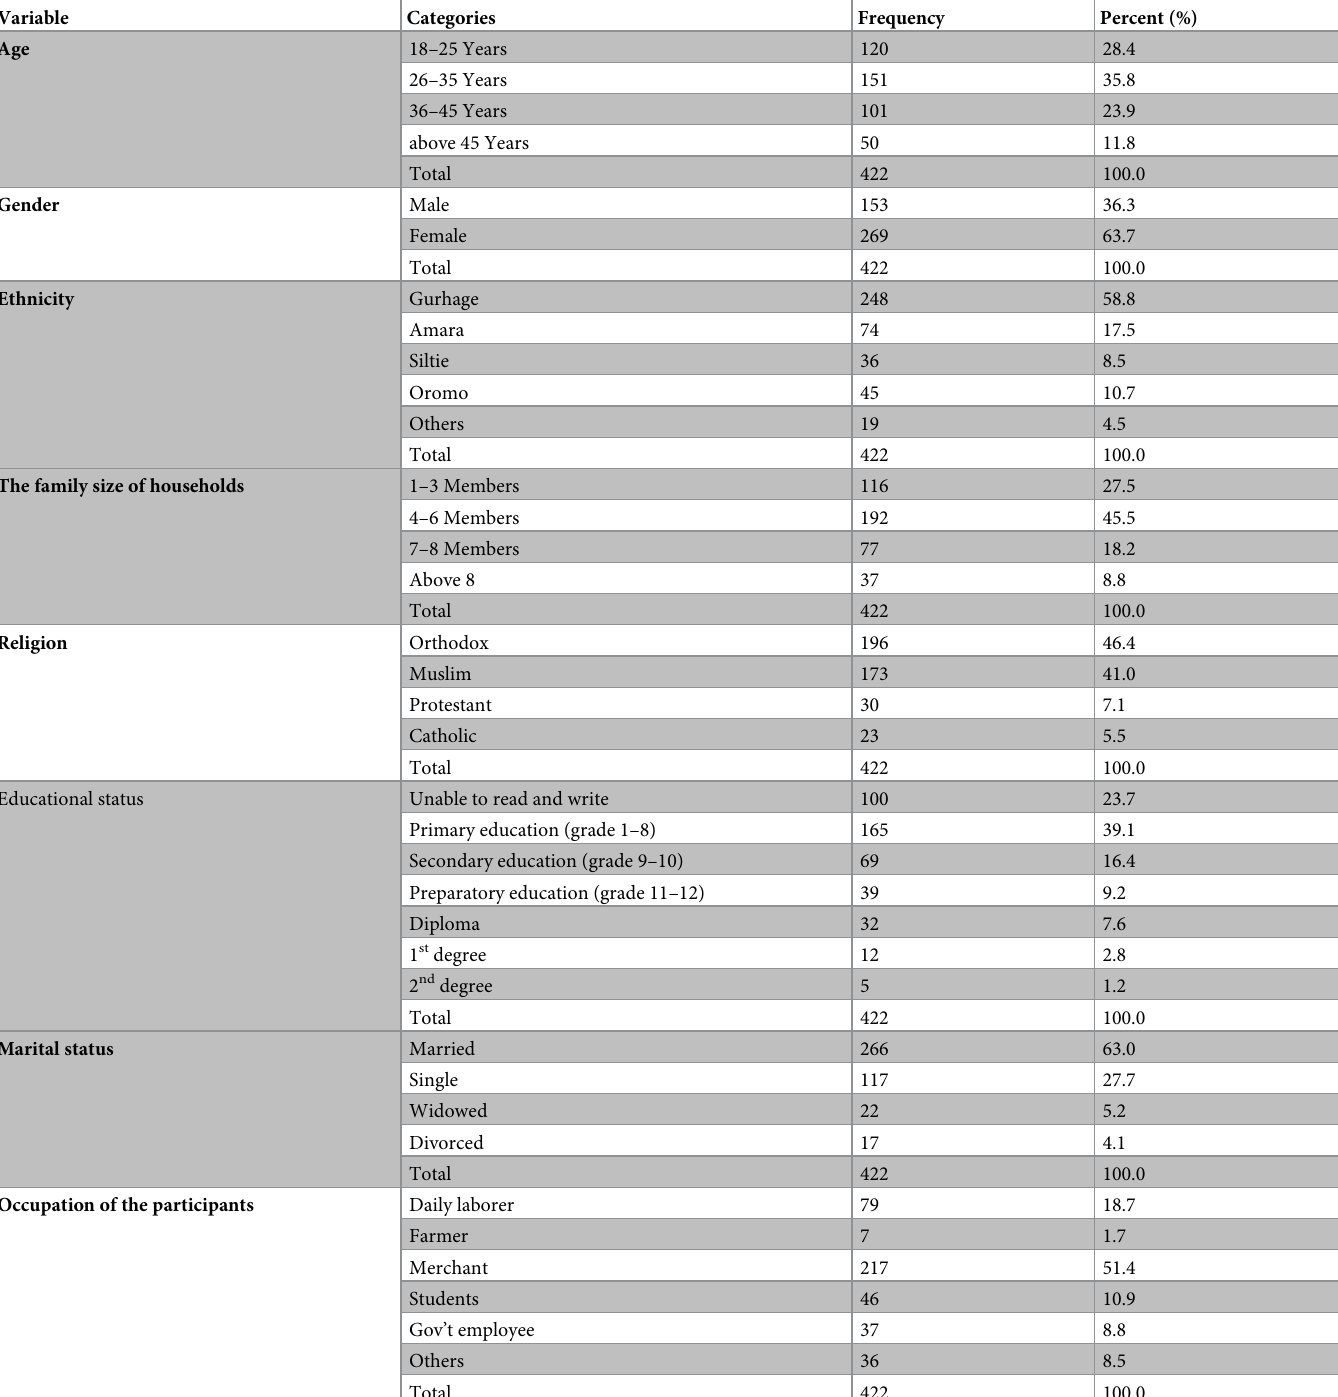
Table 1. Socio-demographic characteristics of participants Butajira town, Southern Ethiopia (N = 422).